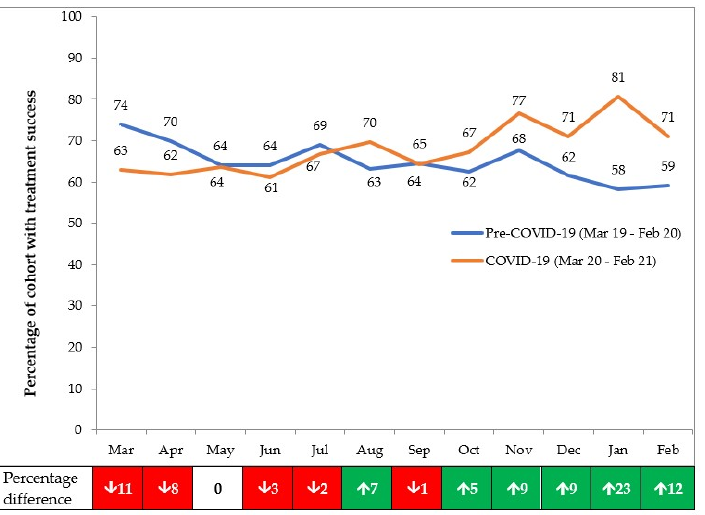
Figure 3. Treatment success among those enrolled each month in 18 health facilities in Nairobi, Kenya, during pre-COVID-19 and COVID-19 periods.